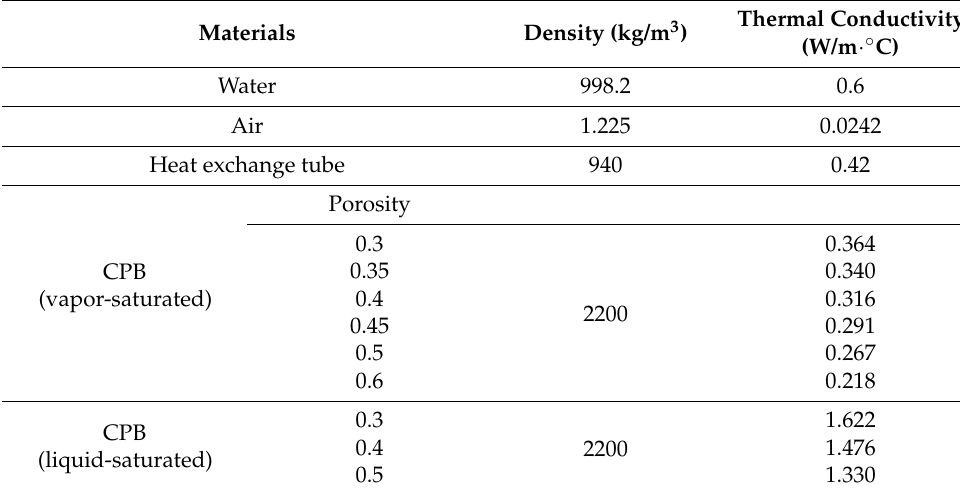
Table 4. Material physical parameters.